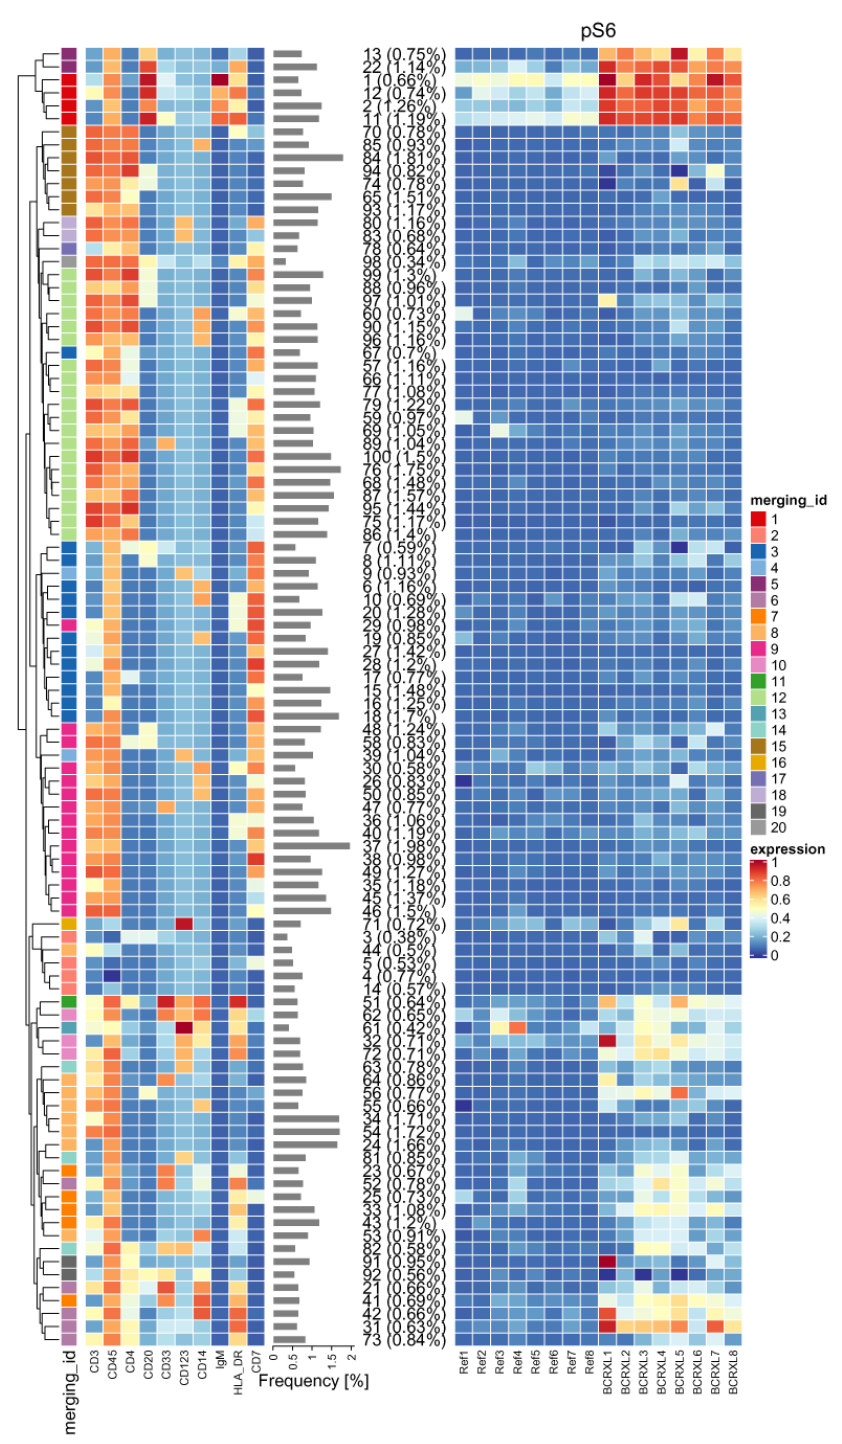
Figure 14. Heatmap of the median marker intensities of the 10 lineage markers (left panel) and one signaling marker pS6 (right panel) across the 100 SOM codes in the PBMC dataset. The color in the heatmap represents the median of the arcsinh, 0-1 transformed marker expression calculated over cells from all the samples, for the lineage markers, and over cells in each sample individually, for the signaling marker. The heat varies from blue for lower expression to red for higher expression. The dendrogram on the left represents the hierarchical similarity between the 100 codes (metric: Euclidean distance; linkage: average). The annotation bar on the left is colored according to the code metaclustering with ConsensusClusterPlus into 20 cell populations. The relative size of the codes is shown in parentheses next to the cluster